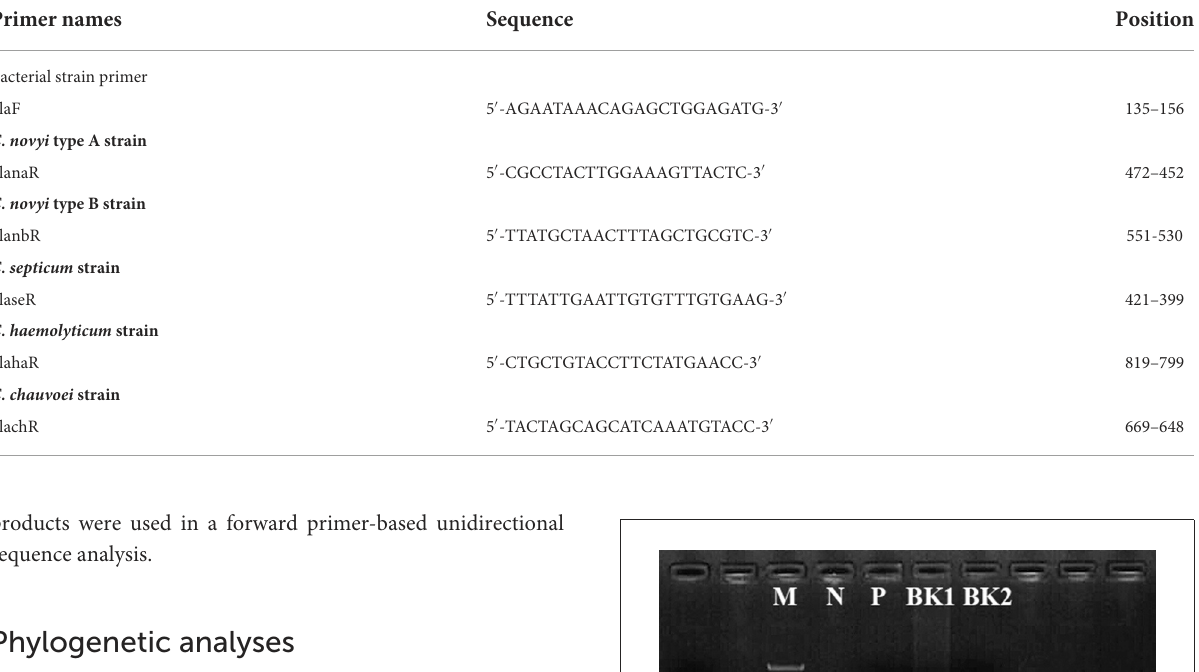
TABLE 1 Primers used for PCR amplification of Clostridium species.